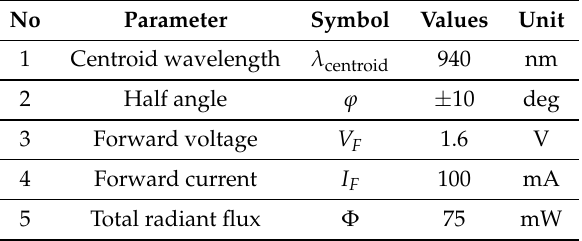
Table 1. The specification of the IR LED (SFH 4544 Infrared Emitter 940 nm by OSRAM Opto Semiconductors) used in experiments. No Parameter